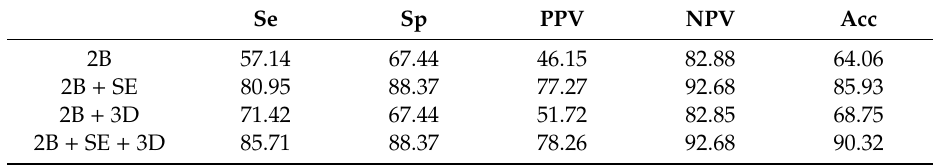
Table 4. Diagnostic qualities of di ff erent models of risk assessment in the studied cases (%). Se